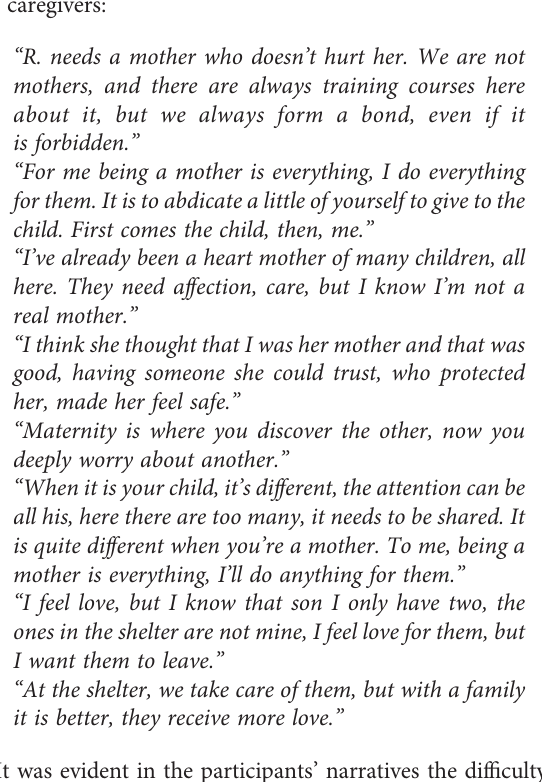
Axis 3: Representation of Separation